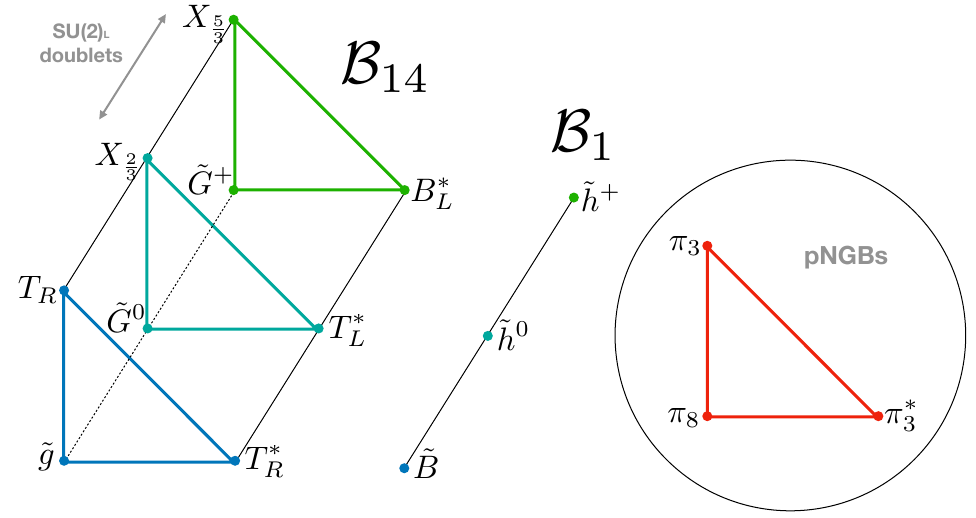
Figure 1. Schematic representation of the B 14 and B 1 chimera baryons in terms of the global symmetries Sp(6) and SO(5) . The triangles represent the 14 of Sp(6) , with the color octet at the square vertex, the triplet at the top and the anti-triplet at the right. The diagonal direction corresponds to the 5 of SO(5) , with the points in the foreground (blue) corresponding to singlets, and the other two composing complex doublets. In the circle, we also show the SU(6) / Sp(6) pNGBs, also transforming as a 14 of Sp(6)